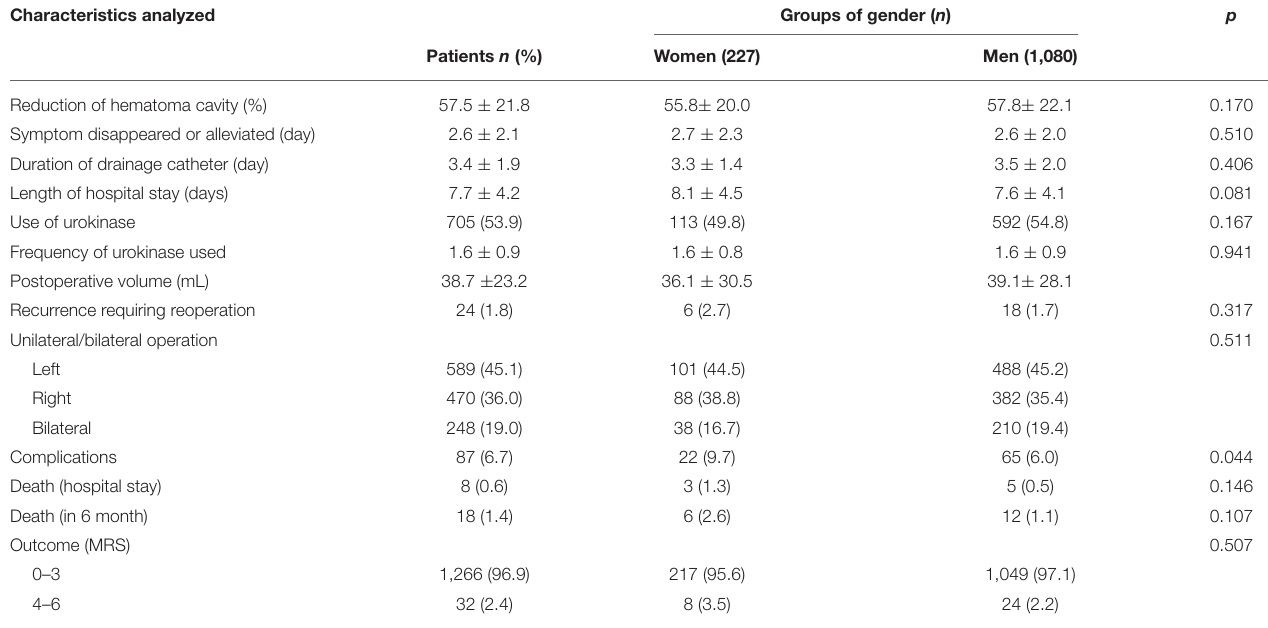
TABLE 3 | The clinical characteristics and relationship between clinical characteristics and groups of gender in patients with chronic subdural hematoma after surgery. Characteristics